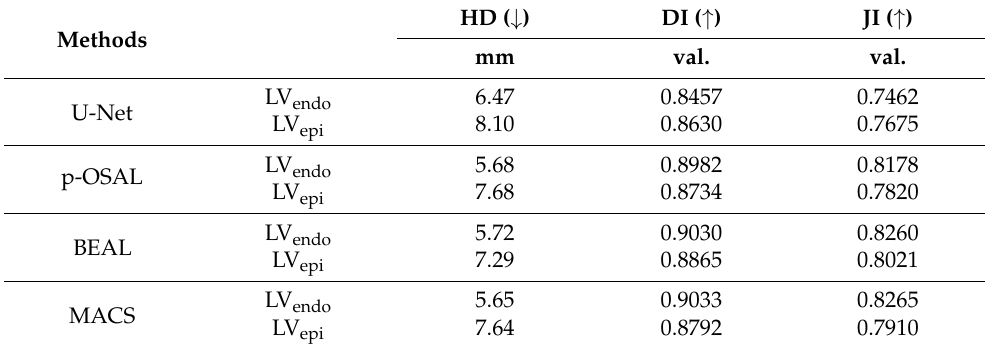
Table 4. Comparison with SOTA adversarial learning methods. The up arrow indicates expecting a higher